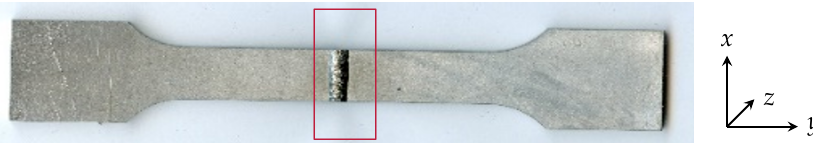
Figure 1. Welded tensile test specimen, area of XCT testing highlighted in